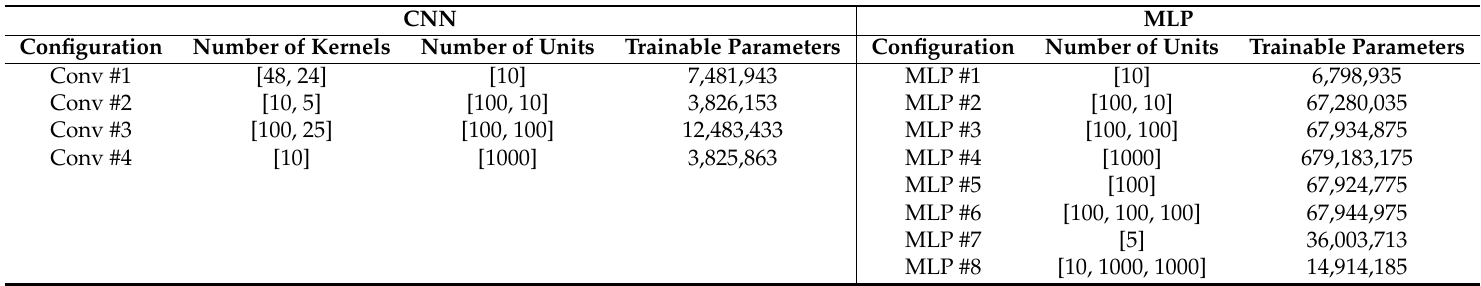
Table 1. The CNN and MLP configurations used in the experiments. The number of parameters are referred to filters of 1024-th